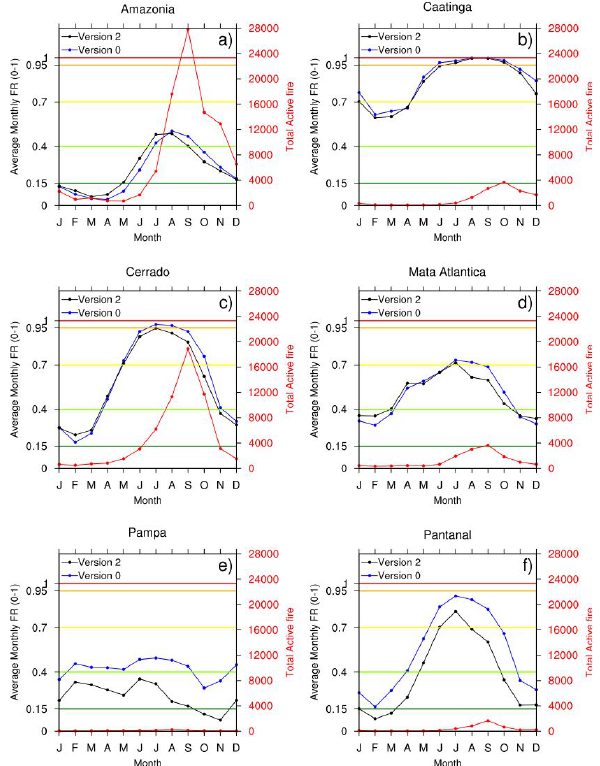
Figure 2. Monthly average Fire Risk (FR) in Brazilian biomes ​ from version 0 (blue) and 2 (black) of INPE’s fire risk model compared to mean total active fires (red) for the 2015-2018 period. FR is expressed in five classes, represented in continuous lines: minimum (FR 0.15, dark green), low≤ (0.15<FR 0.4, light green), medium (0.4<FR 0.70, yellow),≤ ≤ high (0.70<FR 0.95, orange) and critical (FR>0.95,